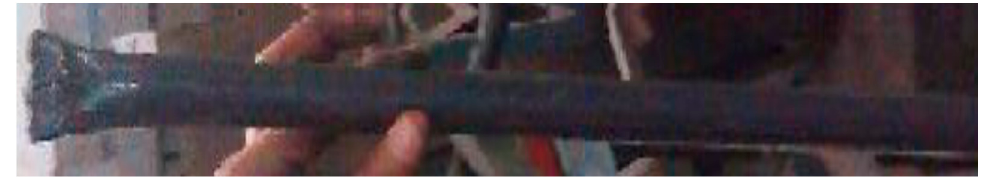
Figure 8. PCM steel tubes used for encapsulating the PCM.